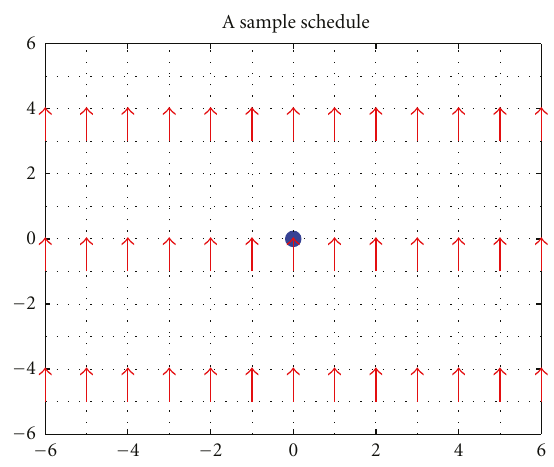
Figure 2: A scheduling pattern in the modified Manhattan